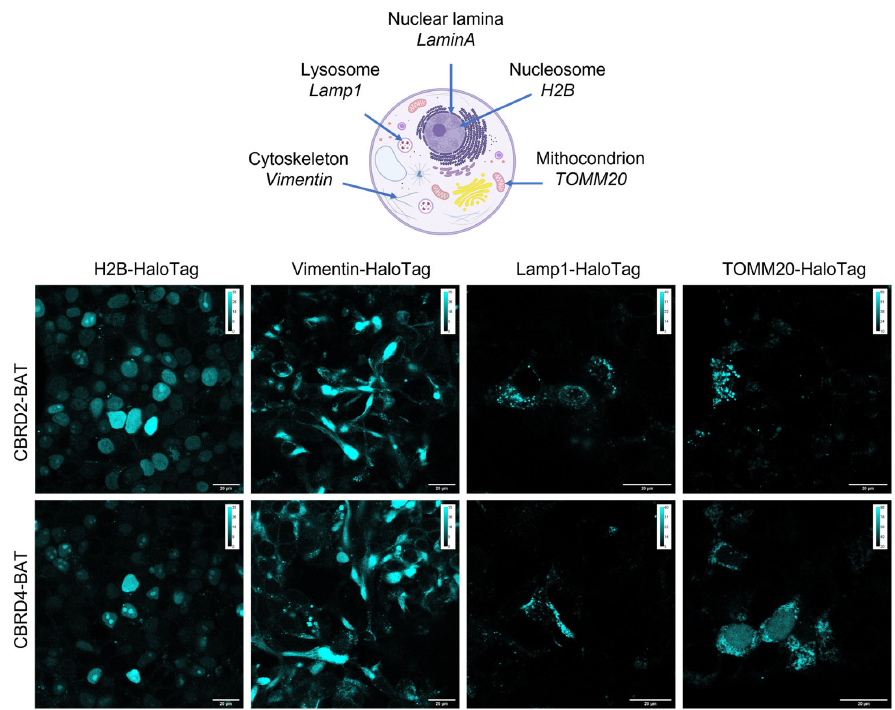
Figure 4. Confocal microscopy images of H2B ‐ , Vimentin ‐ , Lamp1 ‐ , TOMM20 ‐ HaloTag expressing HEK ‐ 293 ‐ OATP3A1 cells pretreated with HaloBCN (3 μ M, 60 min) and treated with non ‐ permeable fluorescent dyes CBRD2 ‐ BAT (3 μ M, 30 min) and CBRD4 ‐ BAT (10 μ M, 30 min) (cyan) in complete DMEM medium (for images of mock cells cf SI Figures S6–S9). Scale bar: 20 μ m; Spectral detection: CBRD2 ‐ BAT and CBRD4 ‐ BAT ; λ exc : 552 nm/ λ em : 565–800 nm. Objective: 100×.